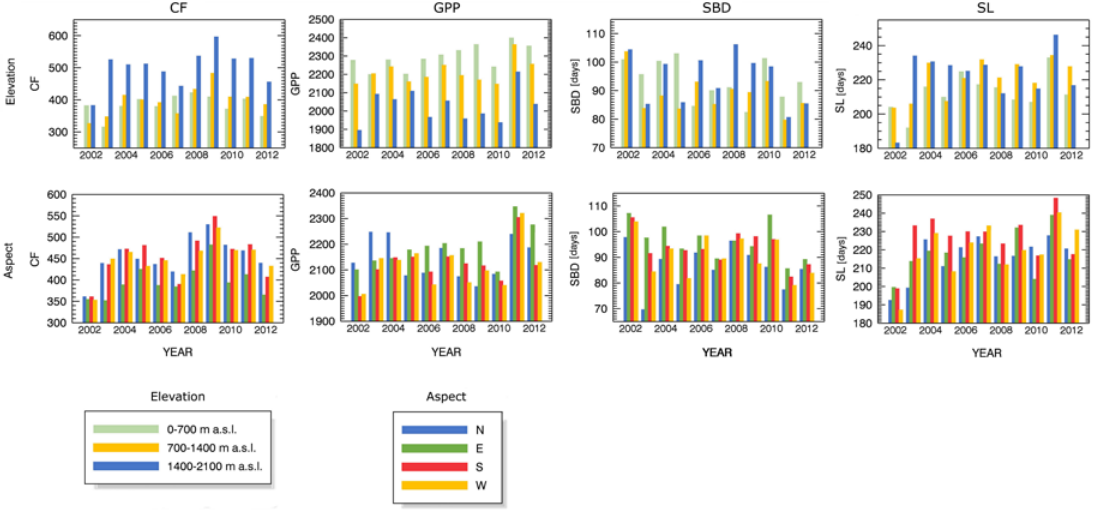
Figure 5. Marginal means plots of repeated measures ANOVA showing CF, GPP, SBD and SL variability (in columns) in relation to elevation and aspect (in rows). Analyses performed for the 4nNDII7 drought impact class 1 spatial footprint. Categories plotted in transparent comprise less than 50 observations. Abbreviations are explained in Figure 3.